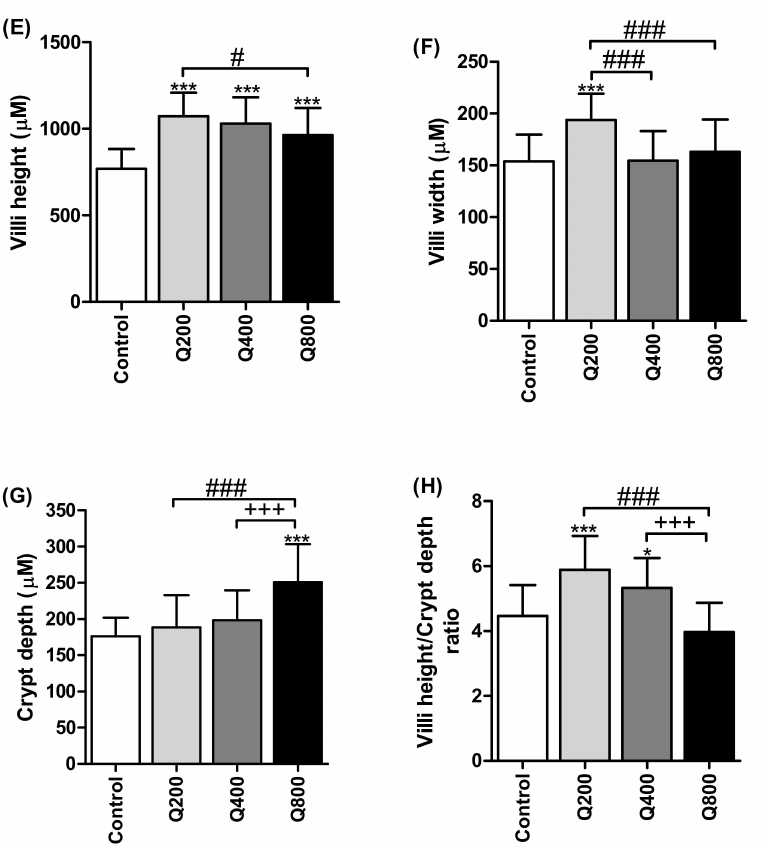
Figure 4. Light microscopic images of small intestine. ( A ) Control. ( B ) Q200 shows the highest villi height and width and the lowest crypt depth. ( C ) Q400 shows the moderate villi height, width and crypt depth. ( D ) Q800 shows the lowest villi height and width and the greatest crypt depth. ( E ) Villi height ( µ m). ( F ) Villi width ( µ m). ( G ) Crypt depth ( µ m). ( H ) Villi height/crypt depth. * p < 0.05 and *** p < 0.001 vs. control. # p < 0.05 and ### p < 0.001 vs. Q200. +++ p < 0.001 vs. Q400. Statistical analysis was performed using one-way ANOVA and Tukey’s post hoc test for multiple comparisons. Q200, birds fed 200 ppm. Q400, birds fed 400 ppm. Q800, birds fed 800 ppm. The black arrows refer to villi. The black arrows’ heads refer to crypts. Scale bar = 400 µ